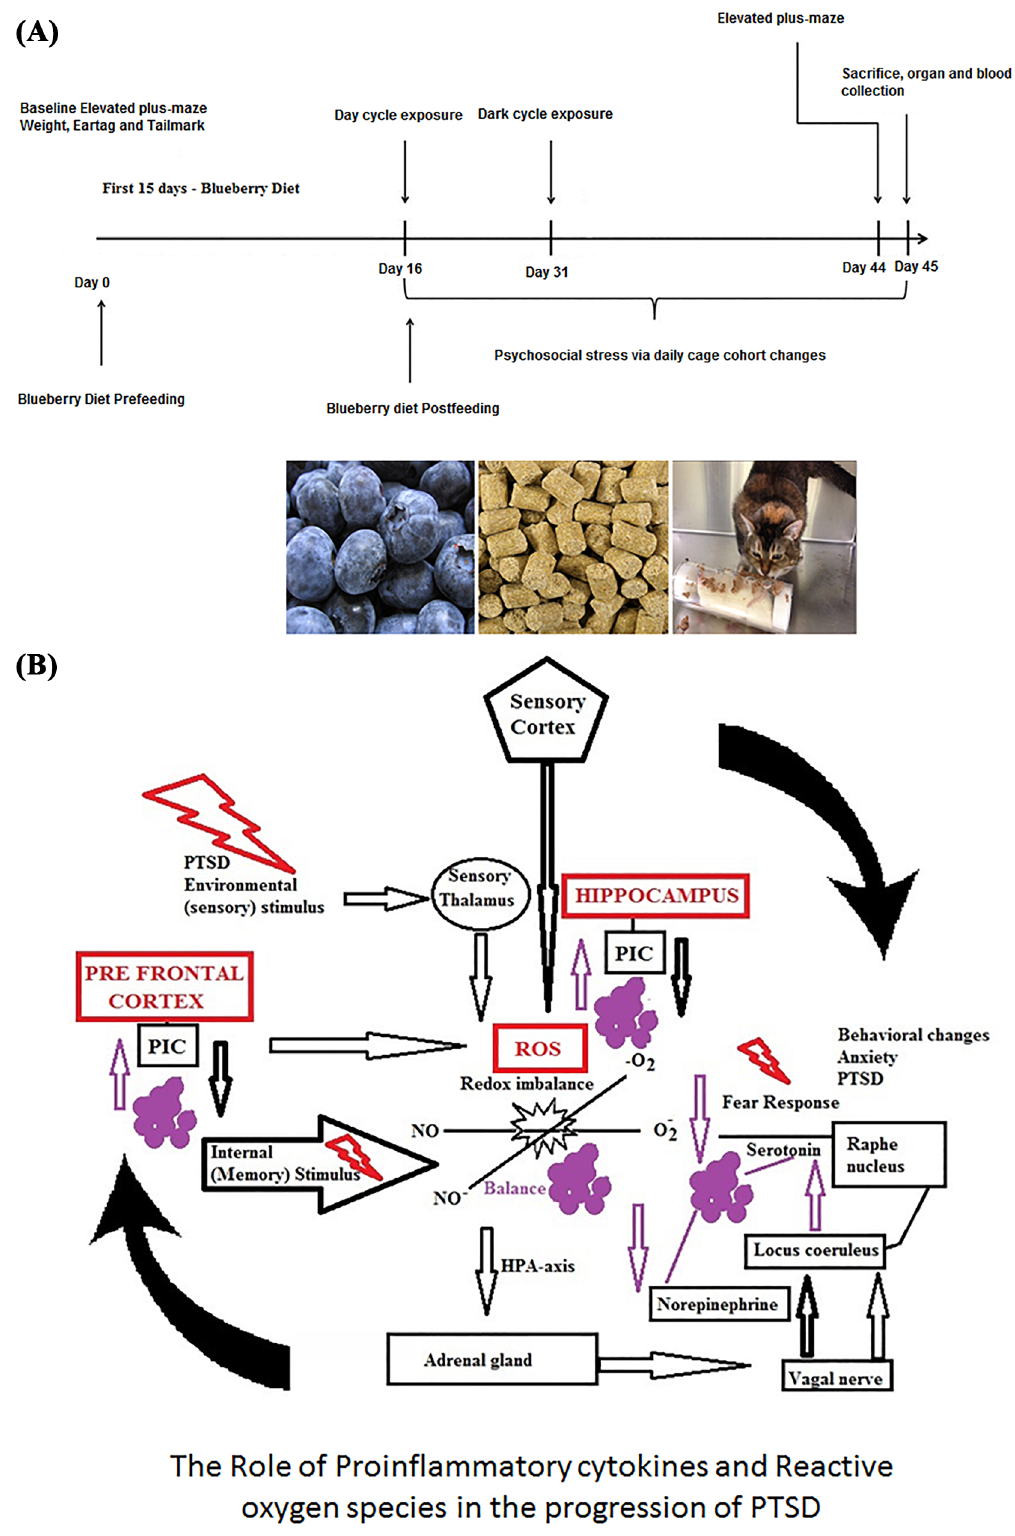
Fig 1. a – Scheme: The predator exposure/psychosocial stress model includes two cat exposures over a 45 and 31 day period, combined with daily cage cohort changes. The experimental animals were fed with 2% blueberry diet 15